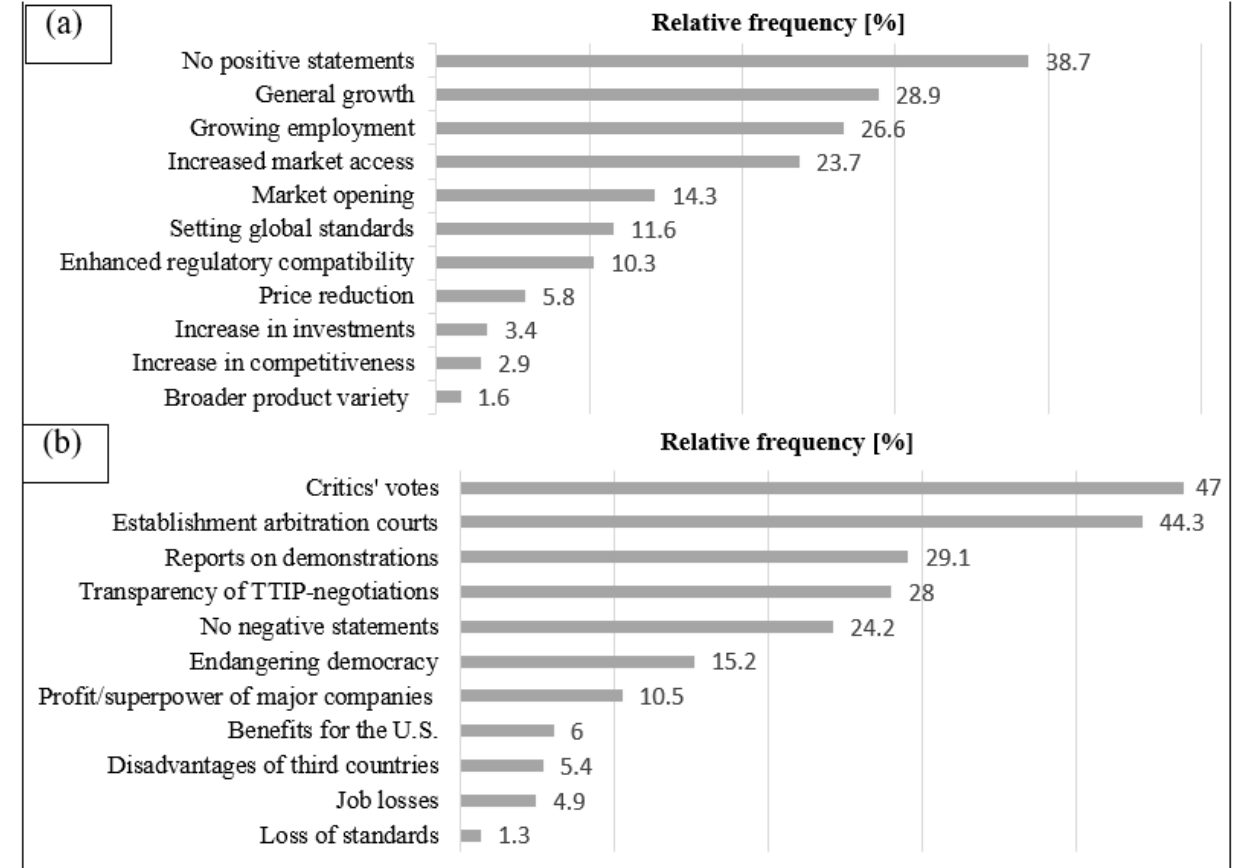
Figure 1. Relative frequencies of positive ( a ) and negative ( b ) statements in print media. Source: own calculations.